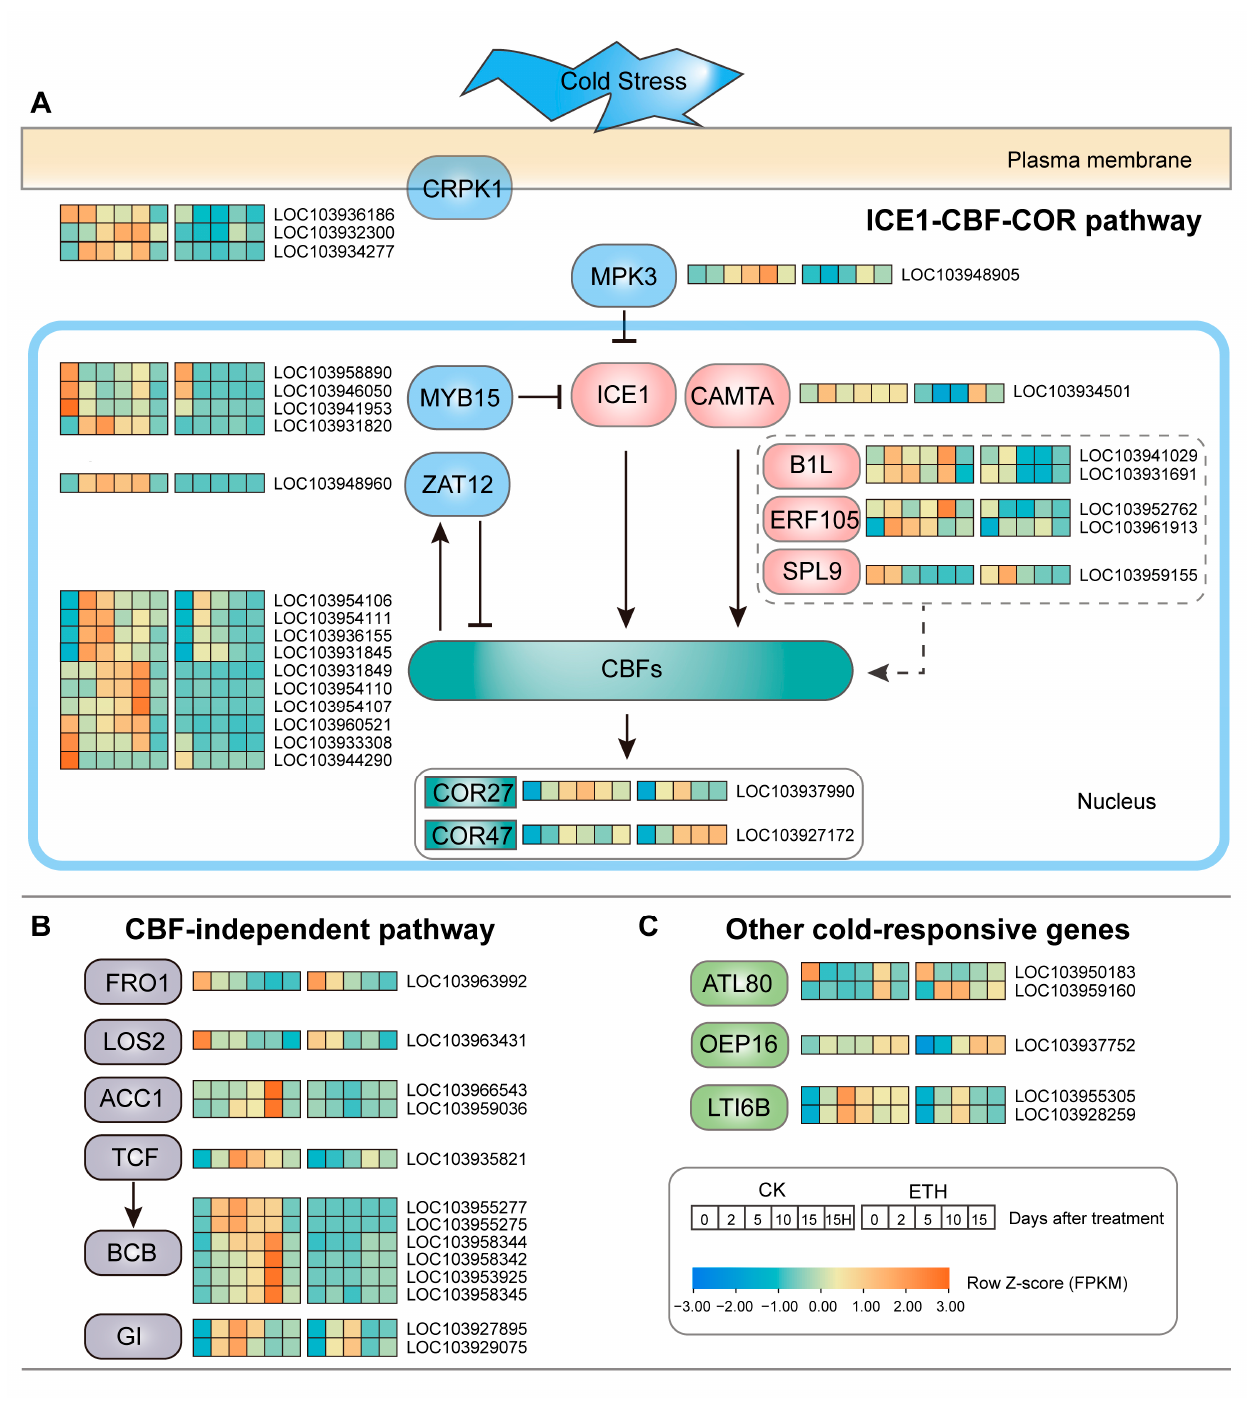
Figure 4. Effect of ethylene on the expression of cold-signaling components during cold storage in ‘Huangguan’ pear. ( A ) ICE1-CBF-COR pathway. The pink ovals and blue ovals represent genes that positively and negatively regulate CBFs , respectively. ( B ) CBF-independent pathway. ( C ) Other cold-responsive genes.